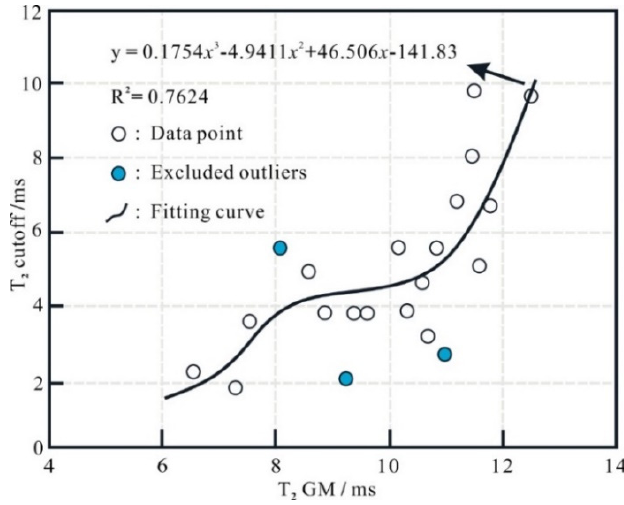
Figure 13. The scatter plot of the relationship between T 2 geometric mean value and T 2 cutoff value.